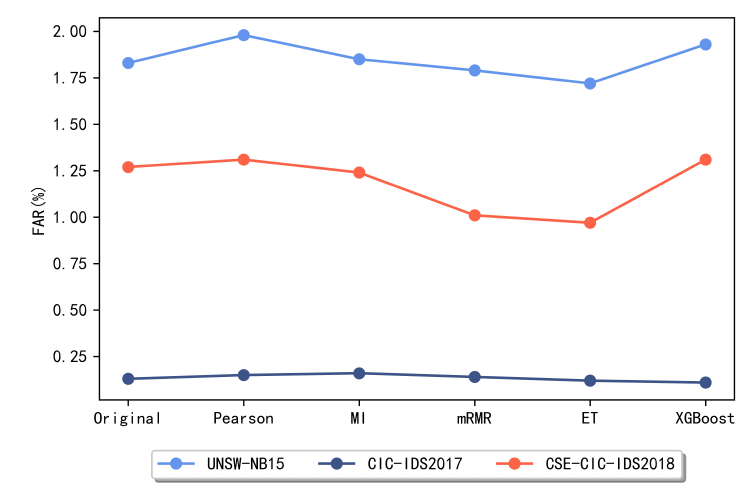
Figure 4. Comparison of false alarm rate of different